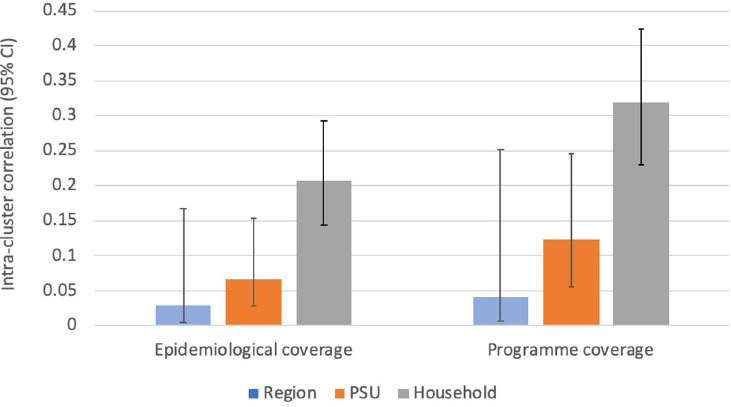
Fig 7. Intra-cluster correlation coefficients for epidemiological coverage and program coverage at region, PSU, and household